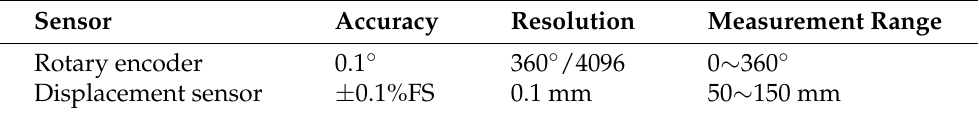
Table 1. The performance parameters of the rotary encoder and displacement sensor.